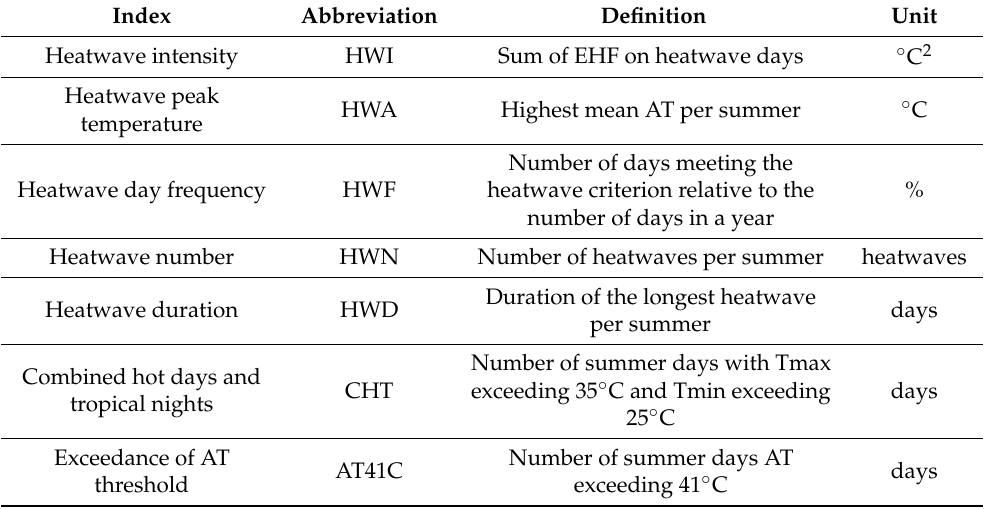
Table 1. Definition of heatwave